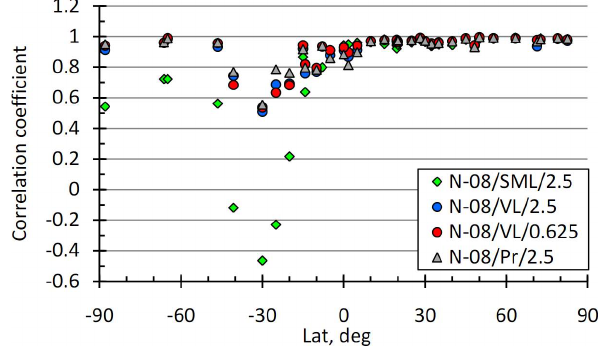
Fig. 7. Correlation coefficients between modeled and observed pat- terns of CO 2 for 2008.